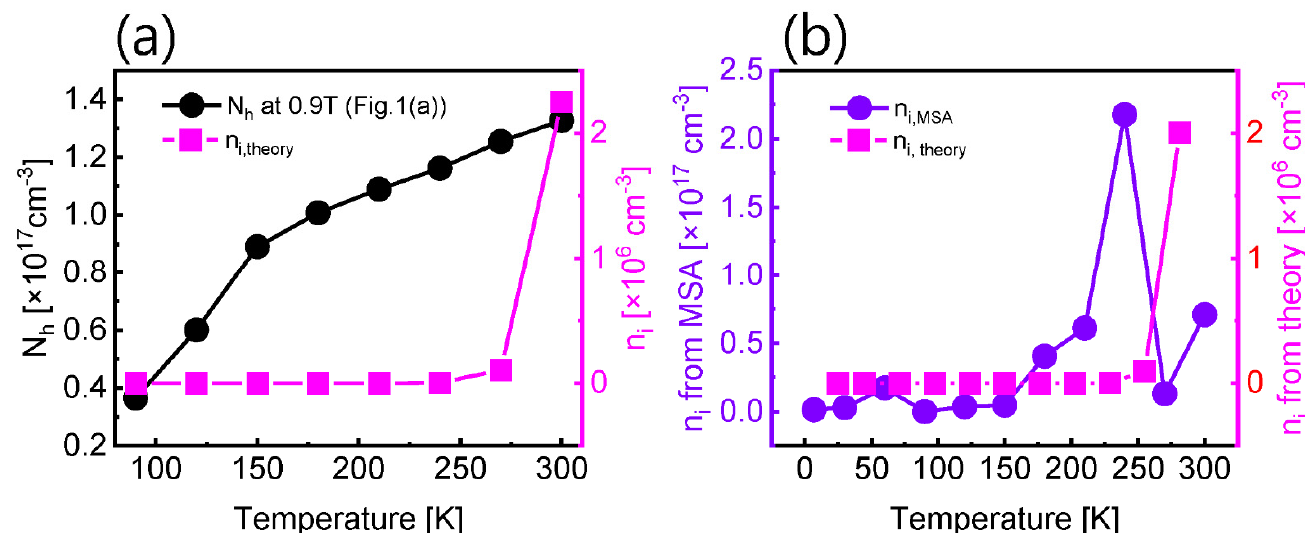
Figure 5. Plot of ( a ) 𝑁 (cid:3035) versus 𝑛 (cid:3036),(cid:3047)(cid:3035)(cid:3032)(cid:3042)(cid:3045)(cid:3052) and ( b ) 𝑛 (cid:3036),(cid:3014)(cid:3020)(cid:3002) versus 𝑛 (cid:3036),(cid:3047)(cid:3035)(cid:3032)(cid:3042)(cid:3045)(cid:3052) . Figure 5. Plot of ( a ) N h versus n i , theory and ( b ) n i , MSA versus n i , theory